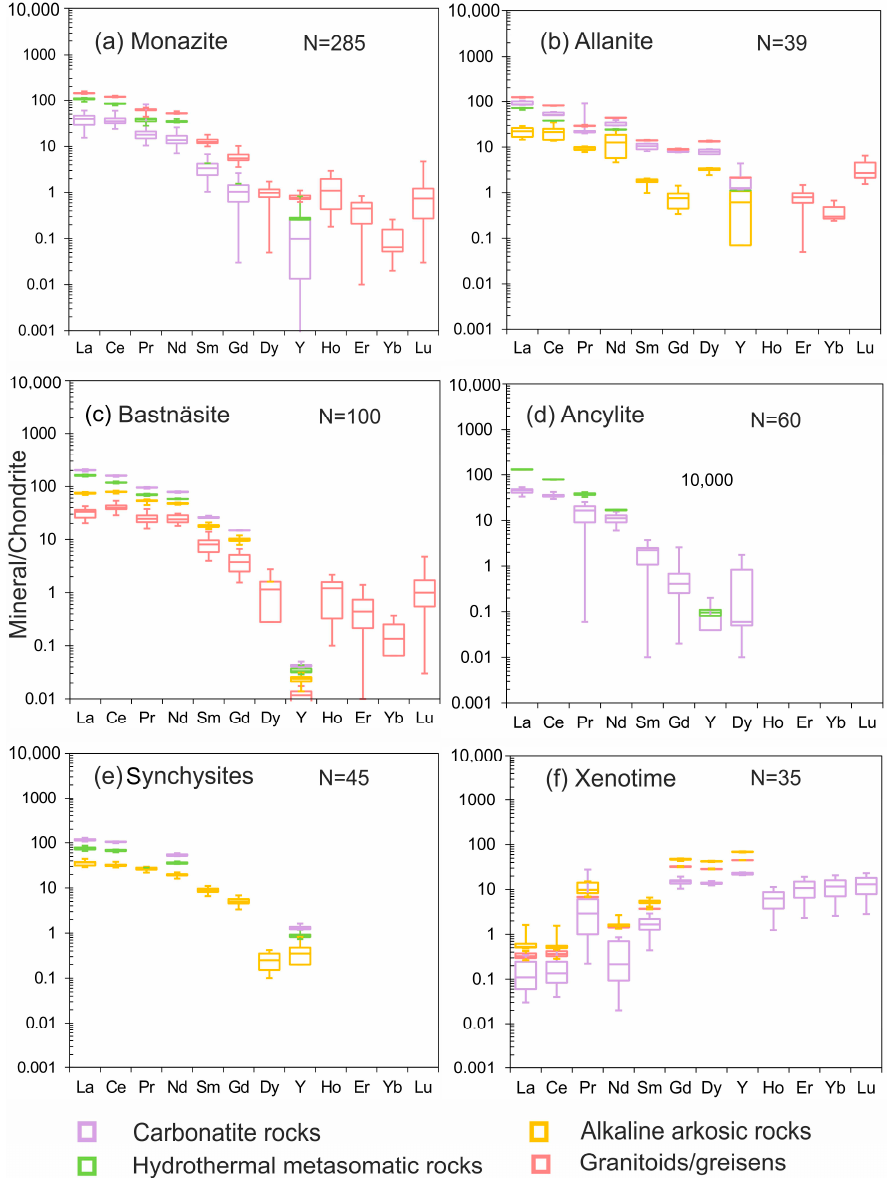
Figure 19. Normalized REE distribution diagrams for average chondrite-normalized REE patterns of ( a ) monazite, ( b ) allanite, ( c ) ancylite, ( d ) bastnäsite, ( e ) synchysite and ( f ) xenotime. Chondrite values normalized relative to mantle compositions after McDonough and Sun [73].